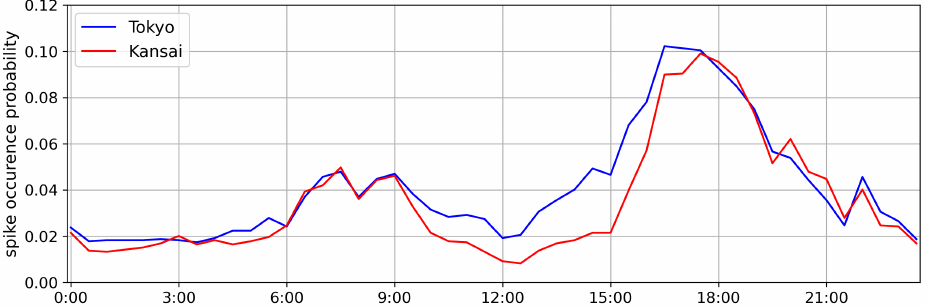
Figure 7. The variation of spike occurrence probability by trading time period for the two selected study areas (Tokyo and